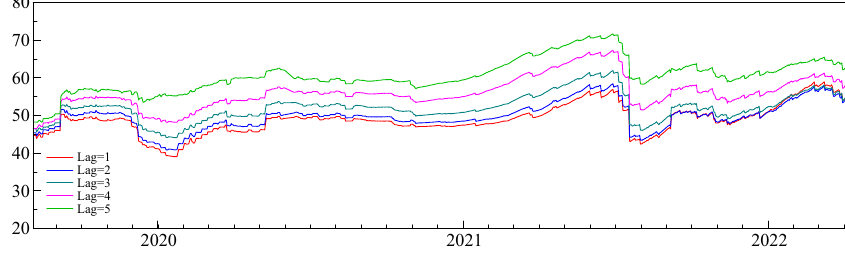
Fig. 38 Dynamic total RK connectedness with different VAR lags